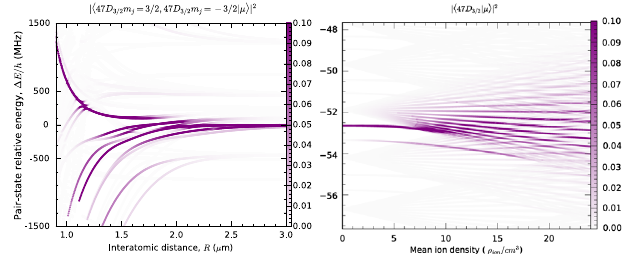
FIG. 8. (a) Potential for pairwise dipole-dipole interactions for 47 D 3 = 2 (left). (b) Stark shifts for assuming an electric field amplitude E ∼ ρ mean ion density based on the corresponding mean spacing between ions. Calculations were made using Alkali Rydberg Calculator [51].